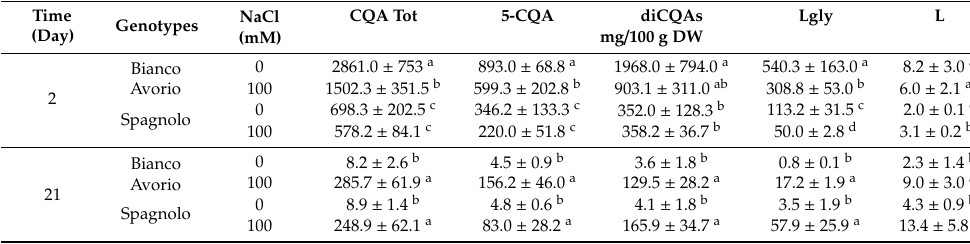
Table 3. Polyphenolic content in leaves of “Bianco Avorio” and “Spagnolo” C. cardunculus var altilis genotypes after 2 and 21 days of 0 (control) and 100 mM (salinity treatment) NaCl. Time